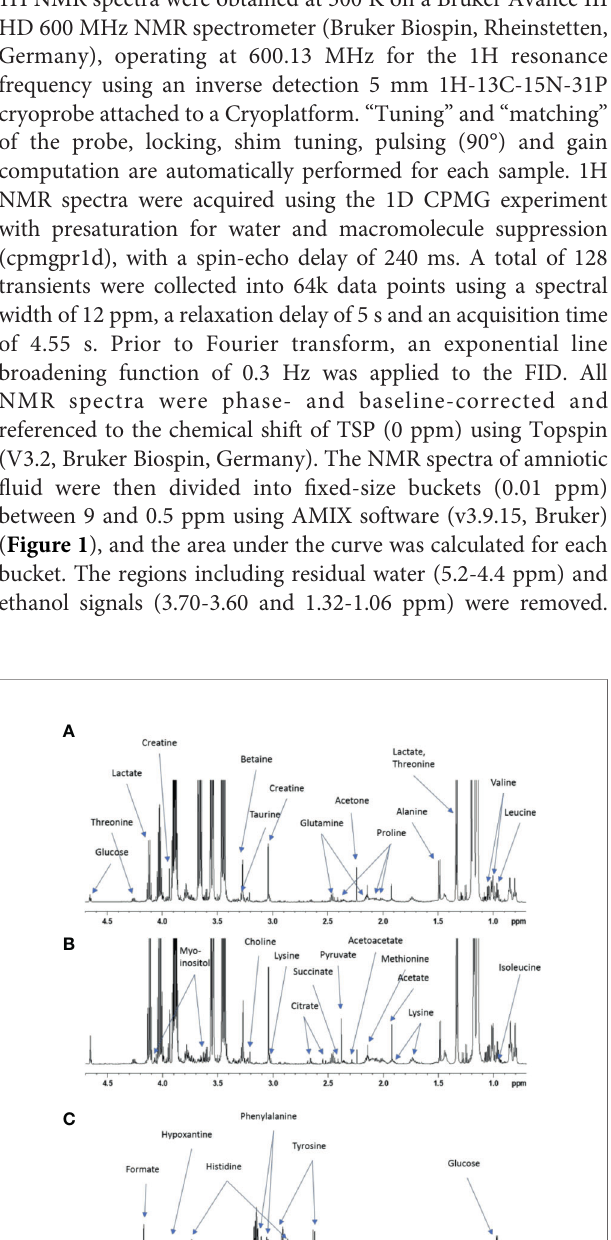
DC FIGURE 1 | NMR spectra of amniotic fl uid collected from dams supplemented or not with GOS/inulin. The 600 MHz NMR spectra of liquid amniotic samples (A) from the control group sample and (B) from the prebiotic group sample; zoom between 4.7 and 0.7 ppm. The 600 MHz NMR spectra of liquid amniotic samples (C) from the control group sample and (D) from the prebiotic group sample; zoom between 9 and 5